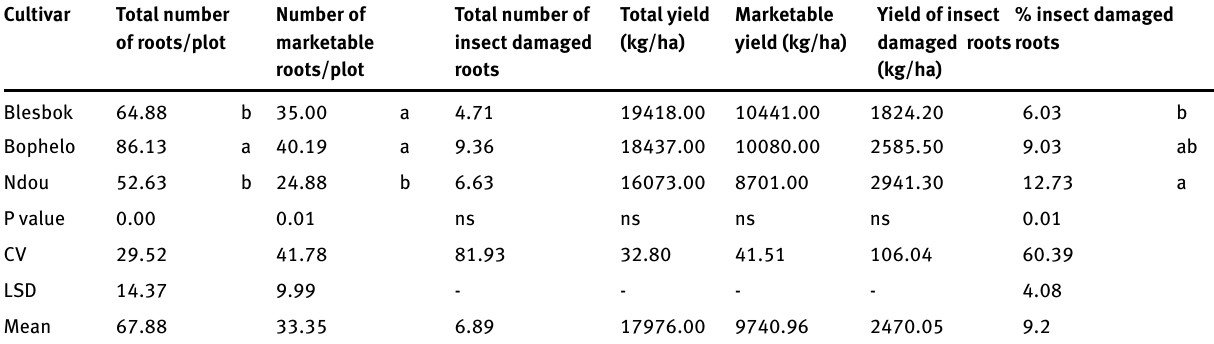
Table 1: Differences among cultivars for root yield and insect damage in a field trial at Roodeplaat, South Africa during 2015 Cultivar